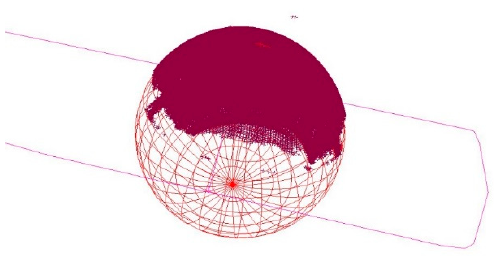
Figure 11. Fitted plane through targets front side and sphere to targets backside.